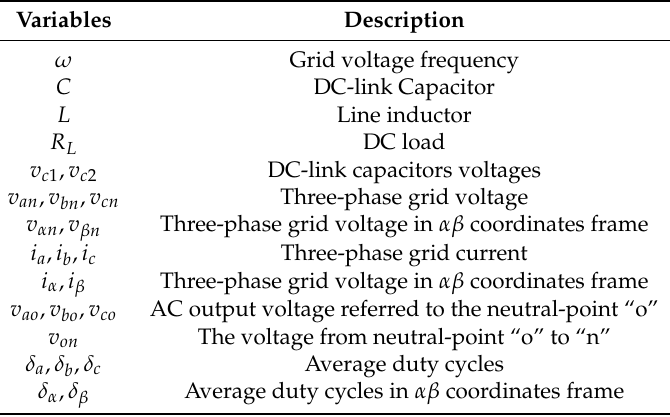
Figure 1. The three-phase three-level NPC converter topology. Table 1. System